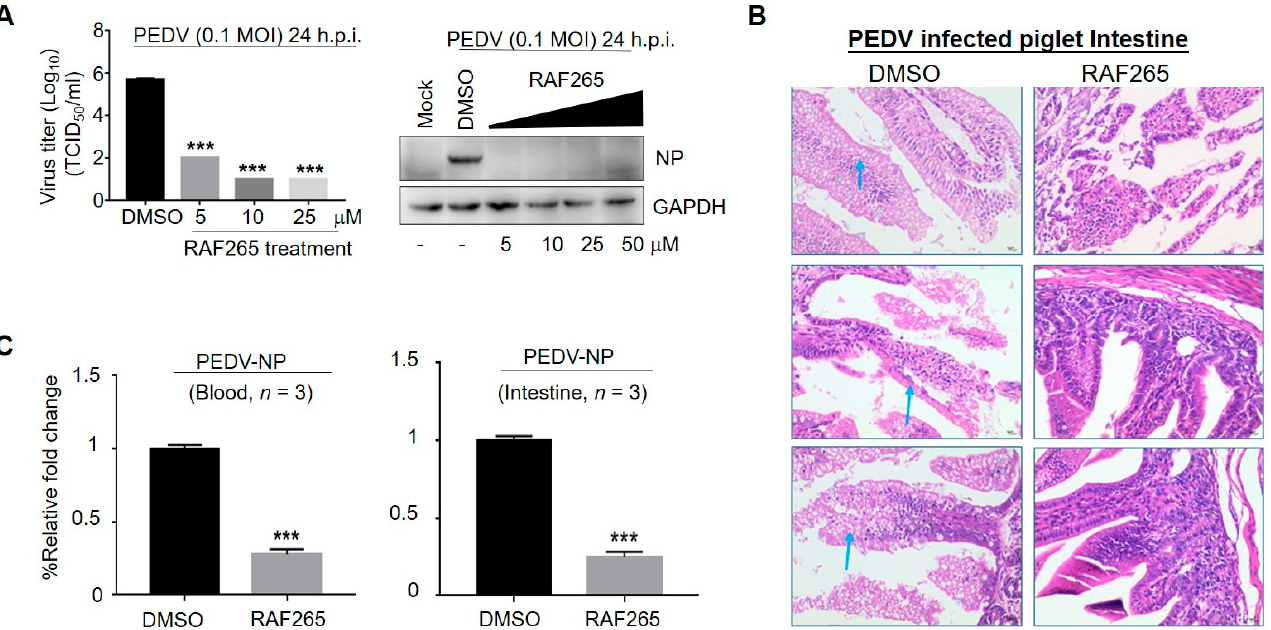
Figure 1. Inhibitory effect of RAF265 on PEDV infection in vitro and in vivo. ( A ) Vero cells were infected with PEDV at 0.1 MOI in the presence of the RAF265 at different concentrations for 24 h, viral yield was measured by TCID 50 assay (left) and level of viral protein PEDV-N was analyzed by WB (right). ( B , C ) Six piglets were divided into two groups of three. One group was intraperitoneally infected with PEDV at 10 5 TCID 50 , and another group was injected with PEDV in the presence of two doses of RAF265 (25 mg/kg) orally at an interval of 1 day. 7 days after infection, the piglets were killed and the Jejunum middle of intestine was harvested and fixed in 4% paraformaldehyde and embedded in paraffin, and then tissue sections were stained with hematoxylin and eosin (H&E) ( B ). Arrows indicate the epithelial cells of the mucosa were necrotic, the cytoplasm was vacuolated, the cytolysis disappeared, and the intestinal glands in the lamina propria were loosely arranged. Blood and intestine were harvested and total RNA was extracted using Trizol reagent, and then PEDV-NP mRNA was detected by qRT-PCR ( C ). h.p.i, hours post-infection; MOI, multiplicity of infection. Significance was evaluated using the t test (mean ± SEM, n = 3). *** p ≤ 0.001.